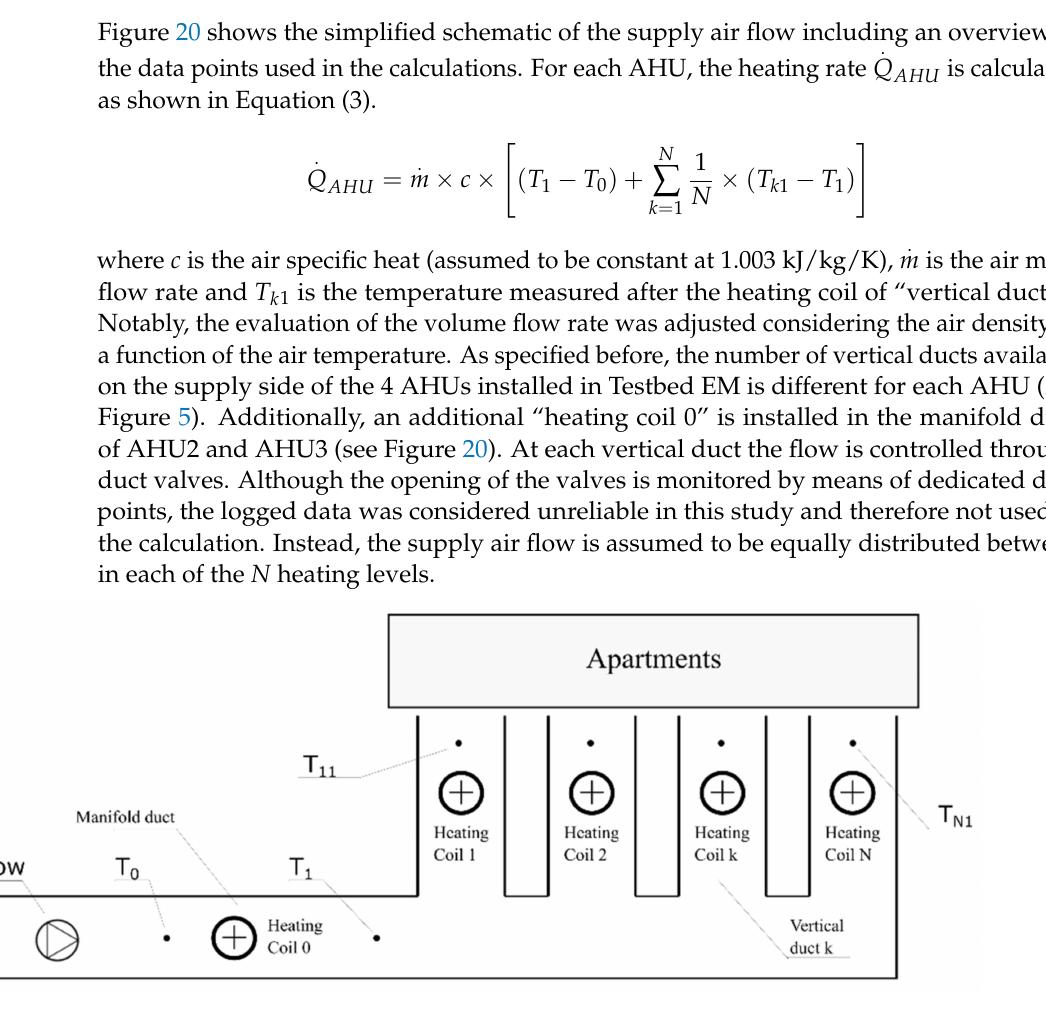
Figure 20. Simplified schematic of the ventilation system, including data points used for the calcula- tion of the energy delivered by the AHUs to the